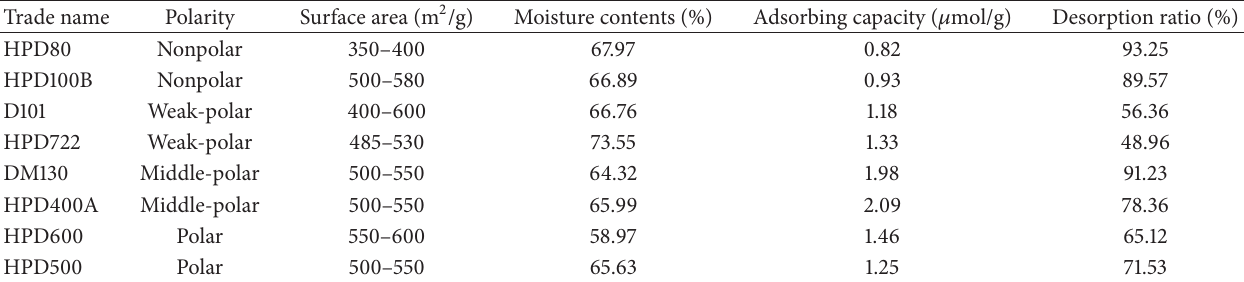
Table 2: Adsorbing capacity and desorption ratio of the test macroporous